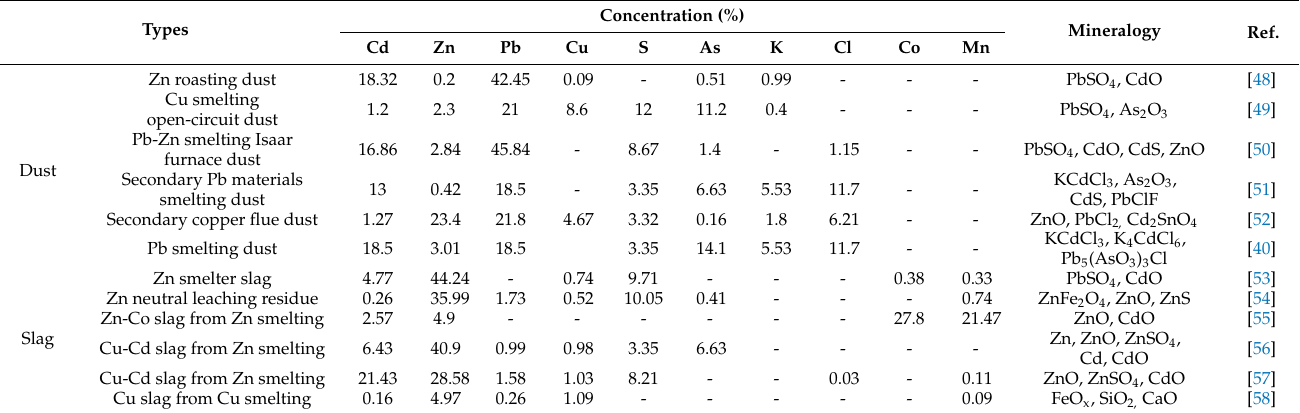
Table 1. Chemical compositions and mineralogy analyses of the Cd-containing dusts and slags.